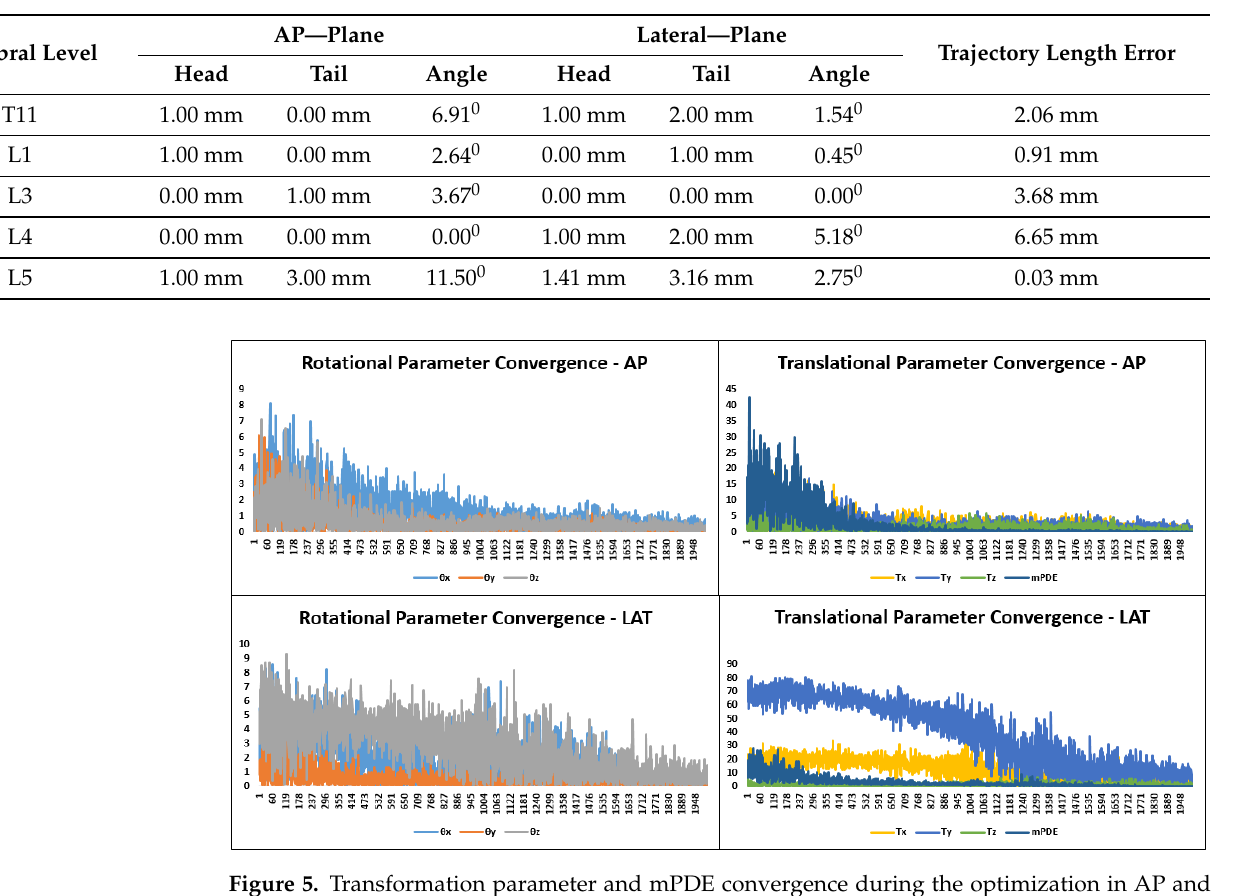
Figure 4. The screw trajectory backtracing from AP ( a ) and lateral ( b ) planes to pCT in L5 vertebra. The gap between the trajectories in different planes is measured and displayed—Source: Orthopaedics and Radiology Department—KMC Manipal. Table 2. Tabulation of trajectory registration error in the AP and lateral planes, and trajectory length error measurement between the actual and the registered trajectories.